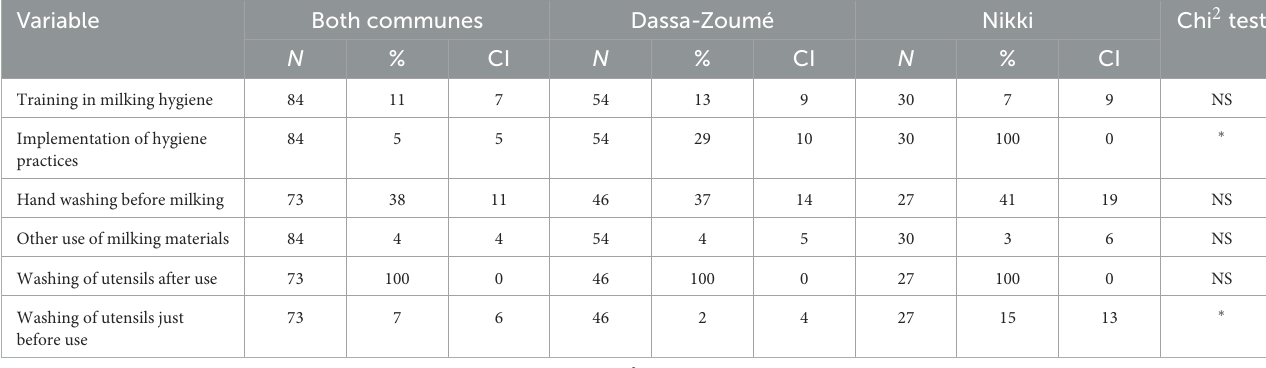
TABLE 6 Milking hygiene measures implemented on farms. Variable